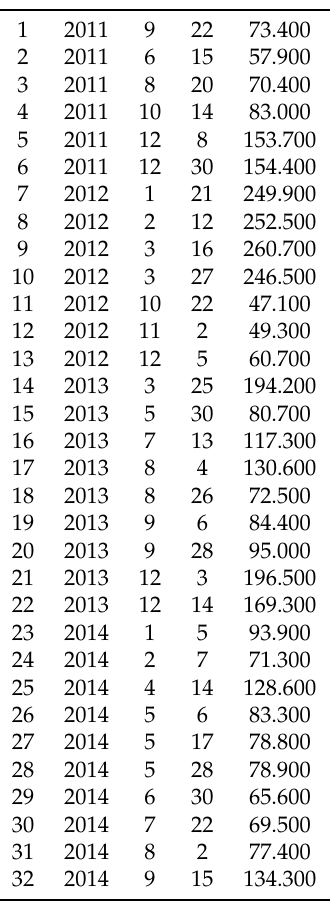
Table A1. List of observation epochs (baselines) used. The columns are (1) Pass number; (2) Year of pass; (3) Month; (4) Day; (5) Ambiguity Height